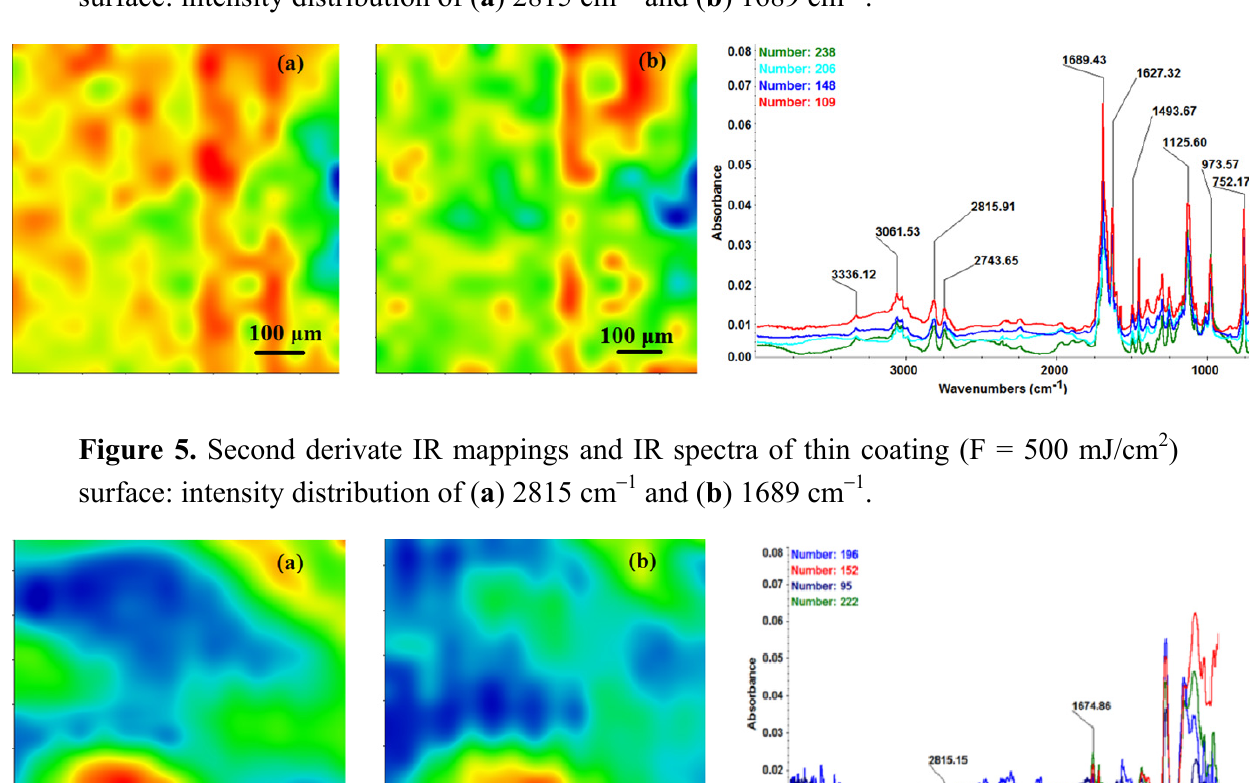
− 1 − 1 and ( b ) 1689 cm .